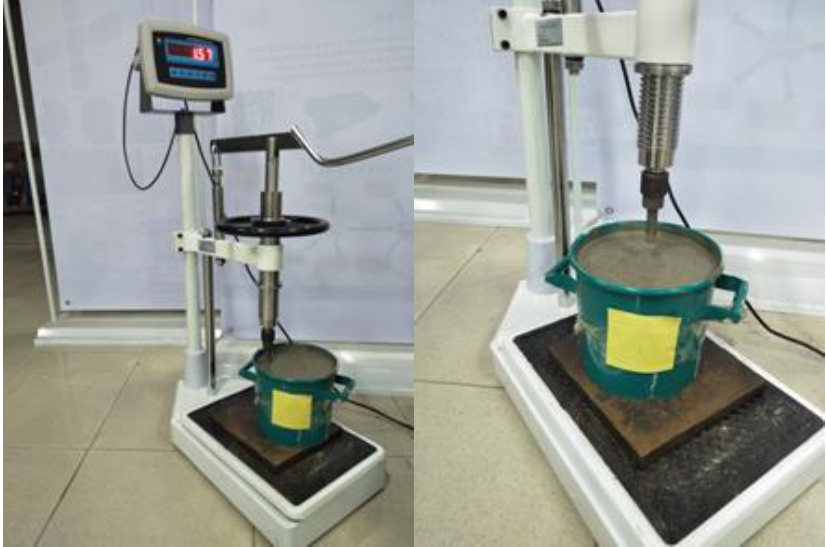
Figure 12. Penetration resistance test.